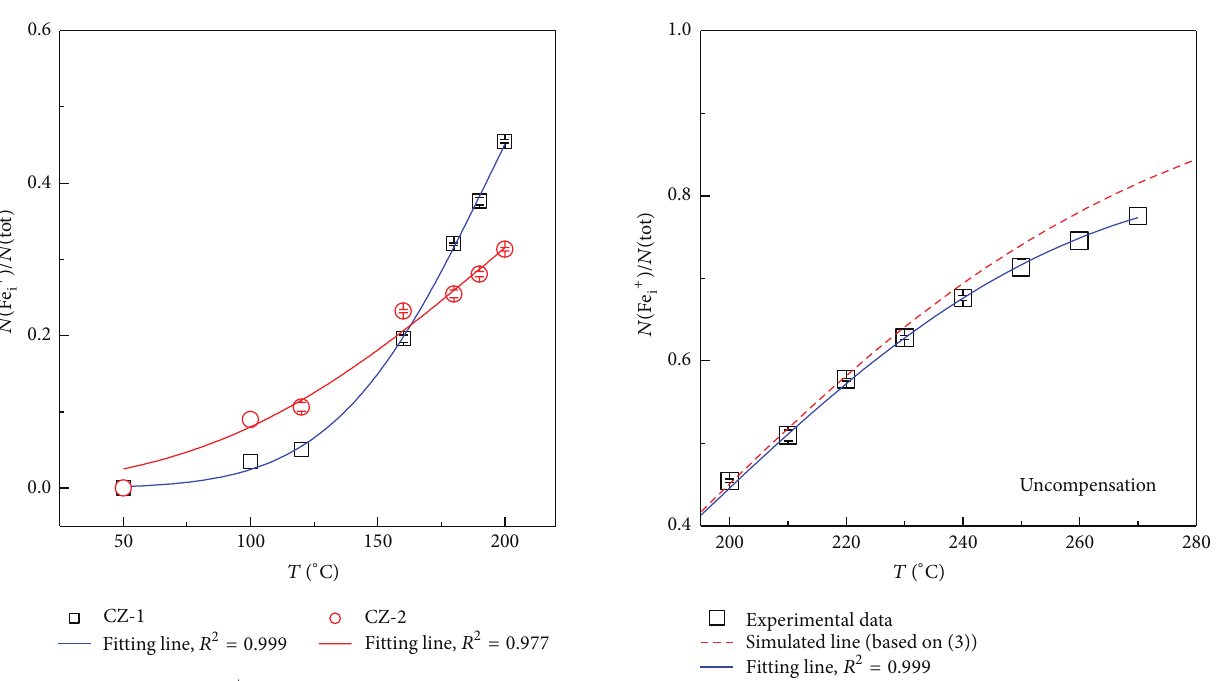
Figure 3: The ratio of N (Fe i + )/ N (tot) as a function of temperature for CZ-1. Black squares refer to the experimental data, the blue solid line represents a best fit, and the red dash line is a simulated line based on the function of N (Fe i + )/ N (tot) = 1/(1 + 2.7 × 10 −6 exp (0.53 eV /𝜅 B 𝑇)